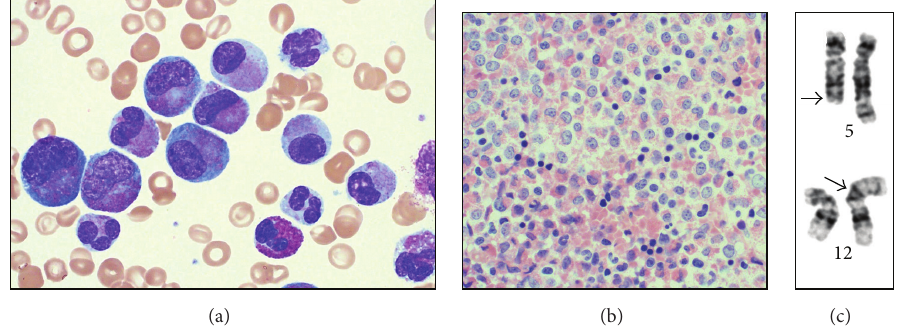
Figure 1: Myeloid neoplasm with t(5;12) and ETV6-ACSL6 gene fusion: morphologic and cytogenetic features. (a) Peripheral blood with a predominant population of eosinophil precursors: large cells with mononuclear, monolobated nuclei and abundant cytoplasm containing eosinophilic granules. The predominant cell type is eosinophil myelocyte, but there is a spectrum of forms including eosinophil metamyelocytes, eosinophils bands, and mature eosinophils. Promyelocytes and myeloblasts are not observed (Wright stain, 1000x). (b) Bone marrow biopsy showing replacement of the marrow space by sheets of eosinophils and eosinophil precursors (hematoxylin and eosin, 500x). (c) Partial karyogram demonstrating t(5;12)(q31;p13) that was identified in 17 out of 20 cells cultured.